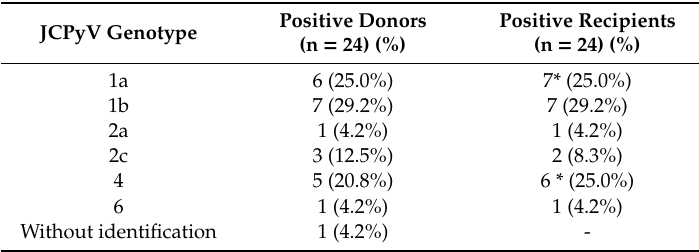
Table 6. JC Polyomavirus (JCPyV) genotypes distribution in urine samples from kidney transplant donors and recipients.